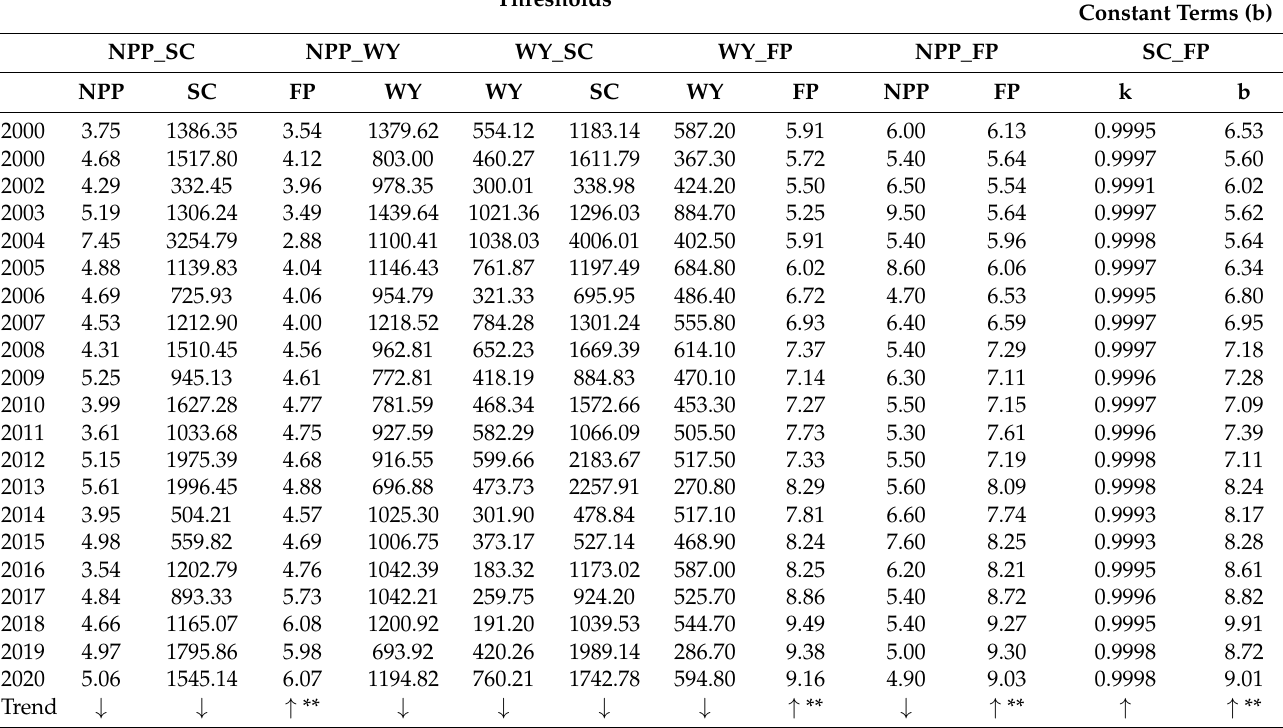
Figure 8. The constraint lines ( a – f ) and scatter plots of key features between paired ESs (X_Y: X represents the ES on x -axis and Y represents the ES on y -axis) and their thresholds (black points) from 2000 to 2020. NPP: net primary productivity; FP: food production; SC: soil conservation; WY: water yield. The units of SC, FP and NPP are t ha − 1 , and the unit of WY is mm. The numbers 0 – 20 represent the years 2000 – 2020, respectively.